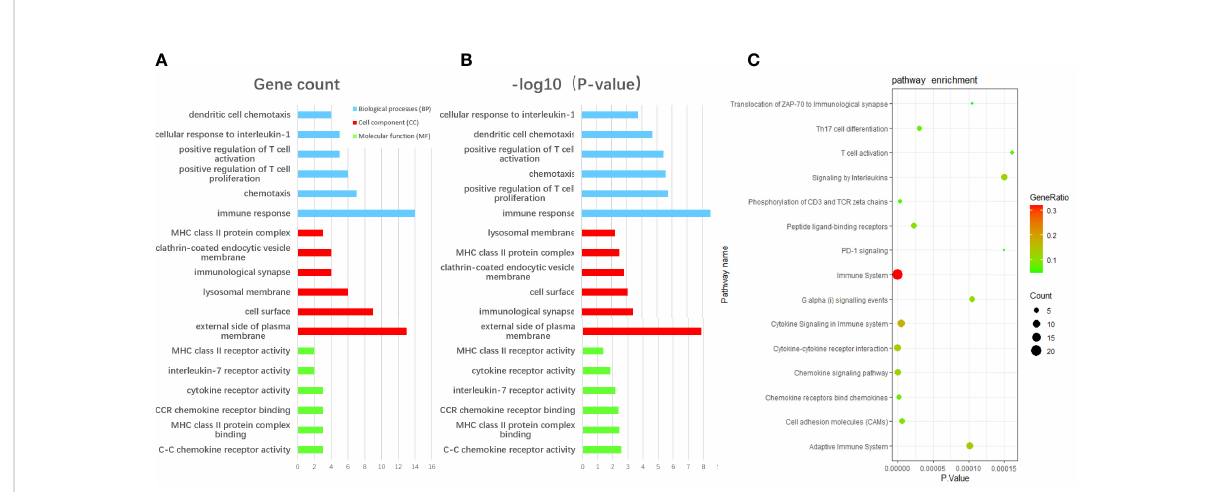
FIGURE 3 The enrichment analysis of communal DEGs between RA and AS. (A) The GO enrichment analyses of communal DEGs with gene count and (B) P-value based on the DAVID database. (C) The pathway enrichment analysis of communal DEGs on the ground of KOBAS 3.0. P-value < 0.05 was considered signi fi cant.